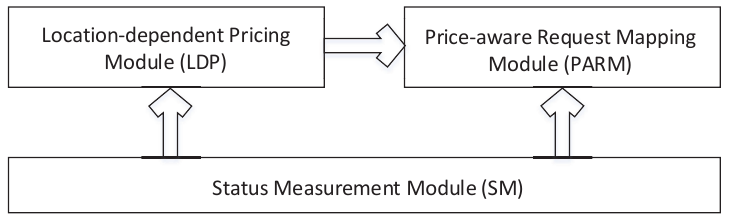
Figure 2. The relationship between the modules in our design. Table 1. Summary of the parameters and decision